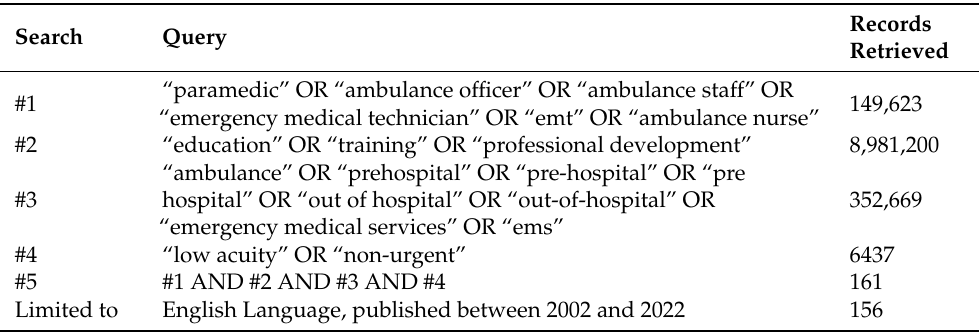
Table 1. Search strategy for Scopus. Search conducted on 16 November 2022.